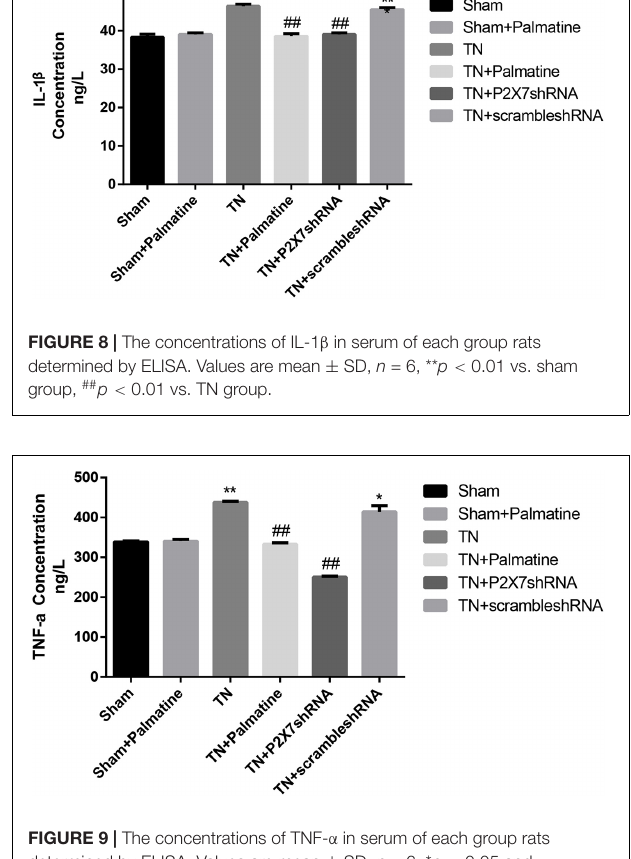
FIGURE 9 | The concentrations of TNF- α in serum of each group rats determined by ELISA. Values are mean ± SD, n = 6, * p < 0.05 and ** p < 0.01 vs. sham group, ## p < 0.01 vs. TN